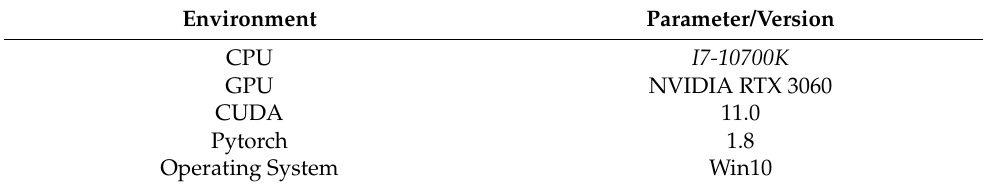
Table 1. Experimental